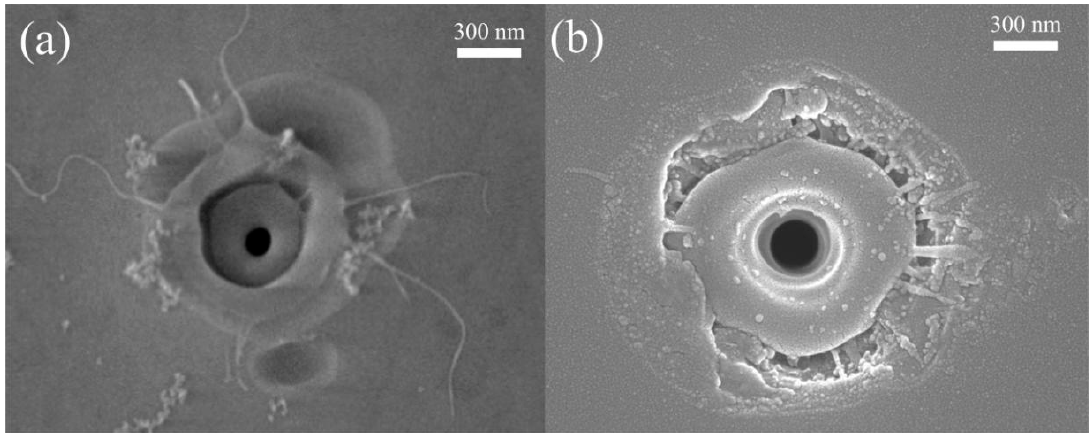
Figure 6. SEM images of the crater on the back surface of fused silica. The single pulse is ( a ) 3 μ J and ( b ) 8 μ J with a pulse duration of 1ps.